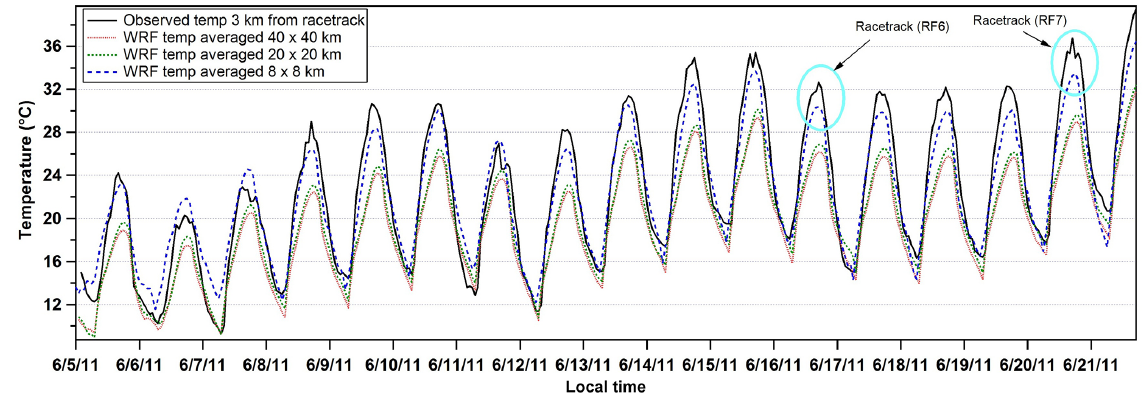
Figure 3. Resolution effect in WRF on temperature bias. The discrepancy between the temperature observed near racetrack and WRF decreased as a function of resolution. At 8 × 8km the bias was very small on most days, but occasionally up to 2 ◦ C was